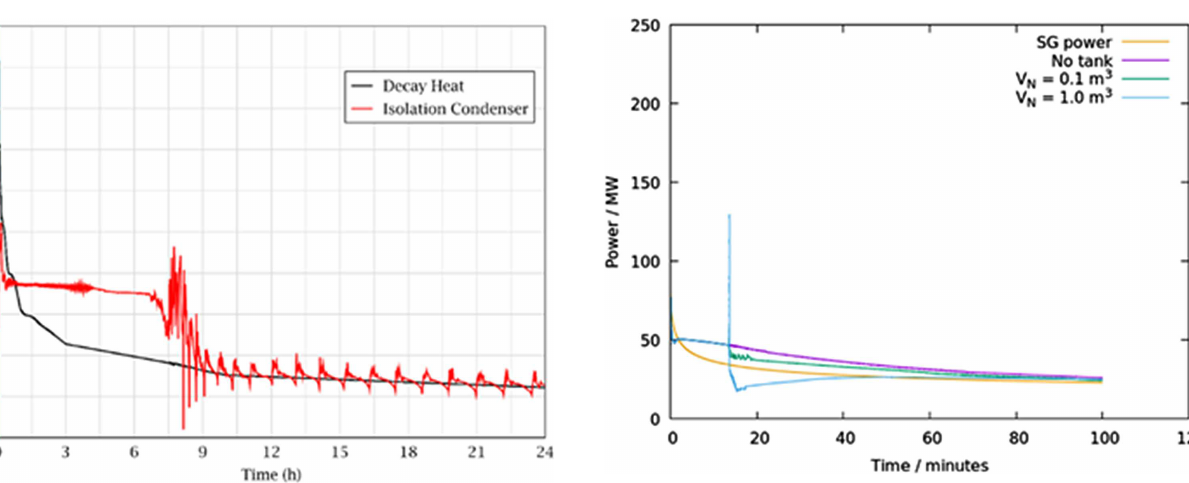
Fig. 3. IC power removal by IC in ALFRED during a PLOOP.